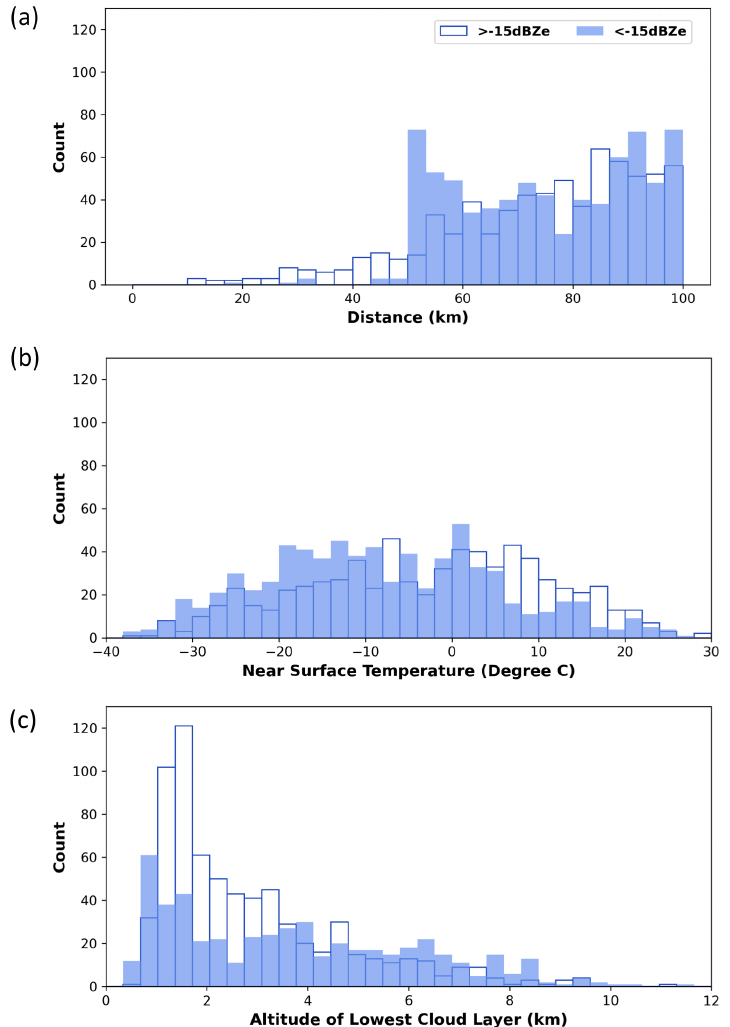
Figure 10. Histogram showing the distributions of: ( a ) the mean distance of each overpass from the ECCC station (km); ( b ) near surface temperature ( ◦ C); and ( c ) altitude of the top of the lowest significant cloud layer (km) for the overpasses where CloudSat detects no precipitation and the ECCC ground observation detects precipitation. The missed detections are divided into two groups: one with reflectivity ≤− 15 dBZ (blue filled bars) and one with reflectivity > − 15 dBZ (hollow